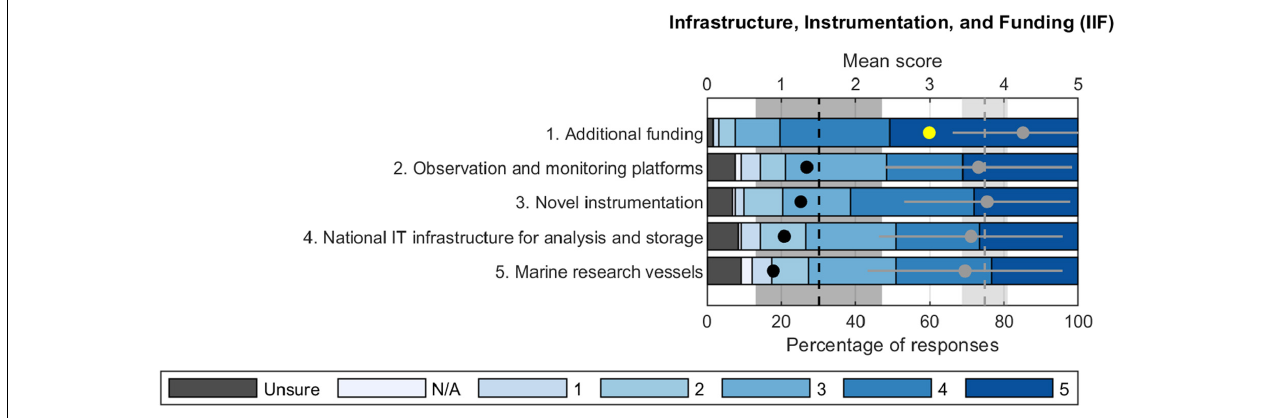
FIGURE 11 | Stacked bar plot showing the distribution of Stage 3 respondent scores for priorities in the Infrastructure, Instrumentation, and Funding (IIF) category. See Figure 5 for full